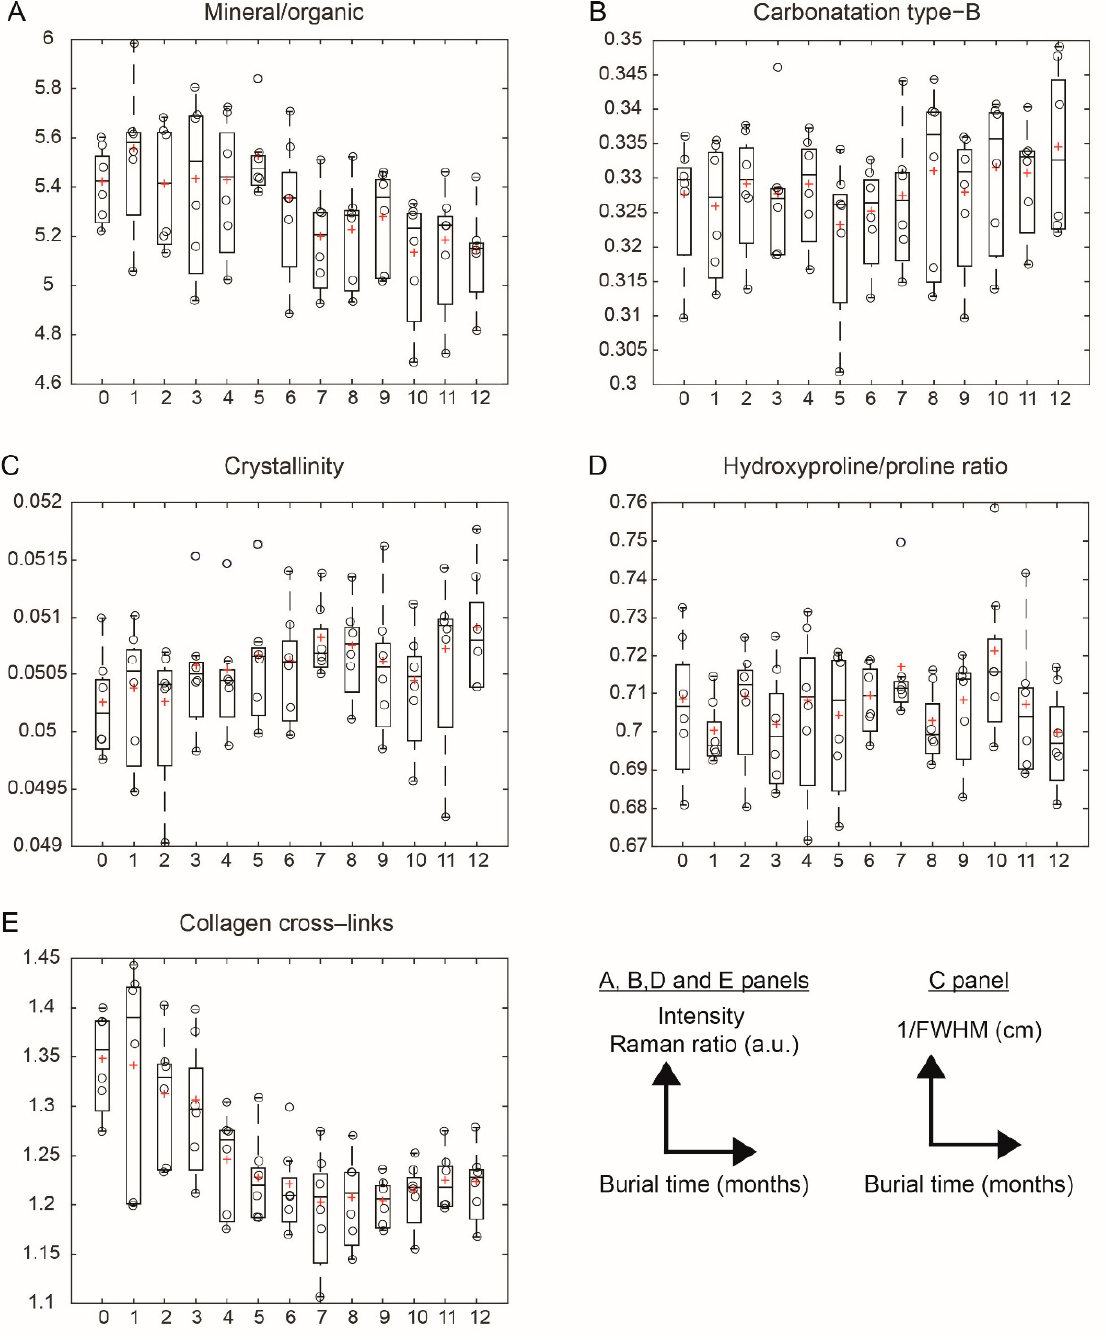
Figure 5. Evolution of the 5 physicochemical variables (PPVs) as a function of burial time in months. One boxplot represents the variations in one parameter at one month. Each circle represents the mean value of a parameter of one body. The red cross represents the mean value of a parameter over the 6 bodies. The horizontal line represents the median value over the 6 bodies. ( A ) Mineral/organic ratio; ( B ) carbonatation type-B; ( C ) crystallinity; ( D ) hydroxyproline/proline ratio; ( E ) collagen cross-links.